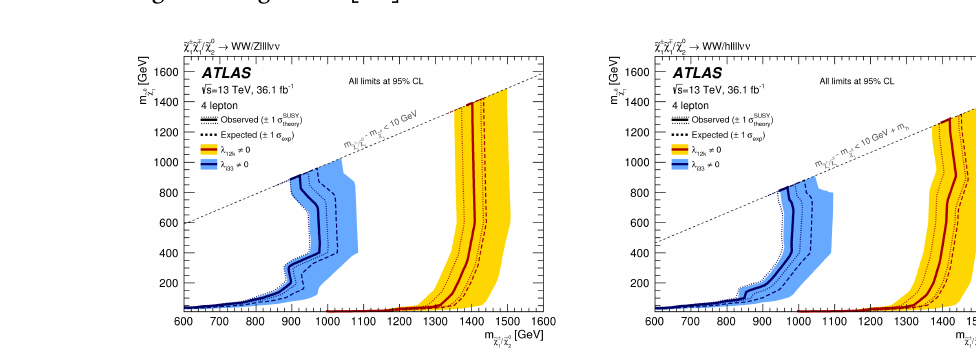
/ ˜ χ 0 [ 21 ] . Figure 22: ˜ χ 0 ˜ χ ± 2 1 1